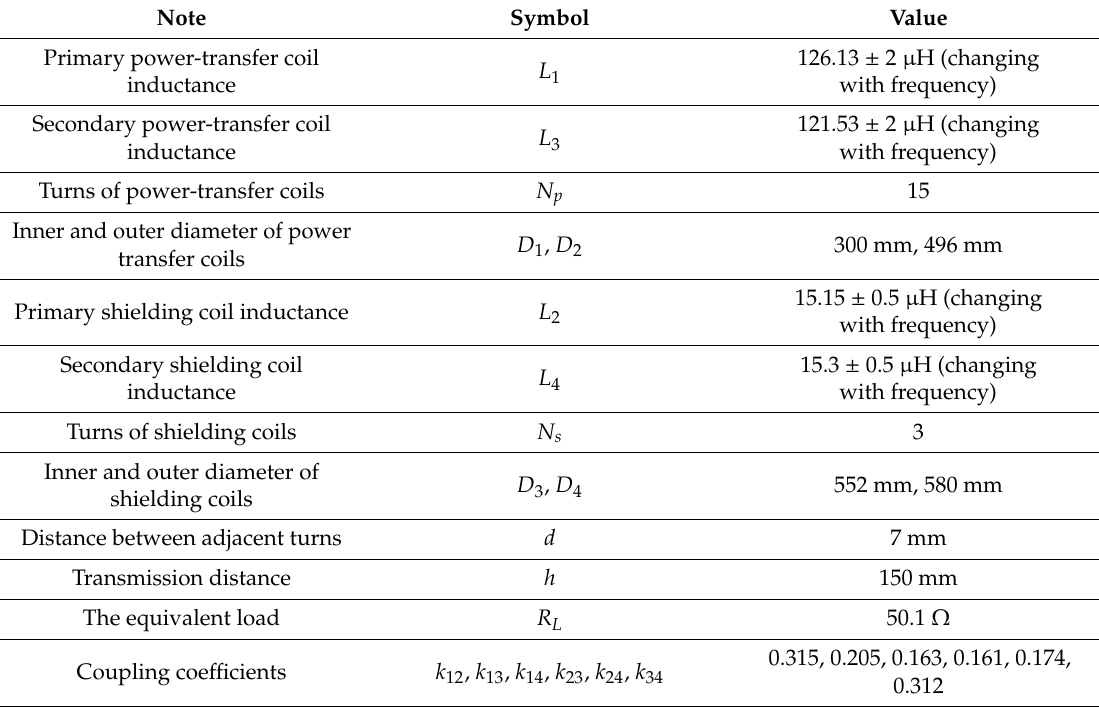
Table 1. Parameters in